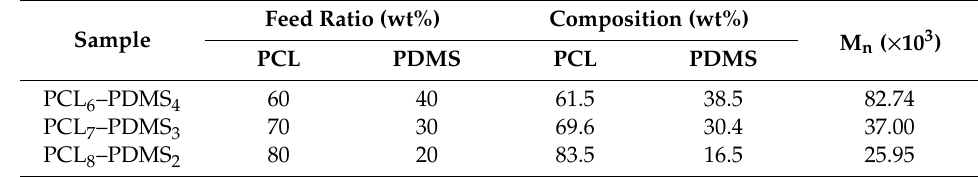
Figure 2. Compositional analysis of the PCL–PDMS copolymer nanofibres by 1 H NMR spectroscopy. Table 1. Compositional analysis of the PCL–PDMS copolymer nanofibres by 1H NMR spectroscopy.